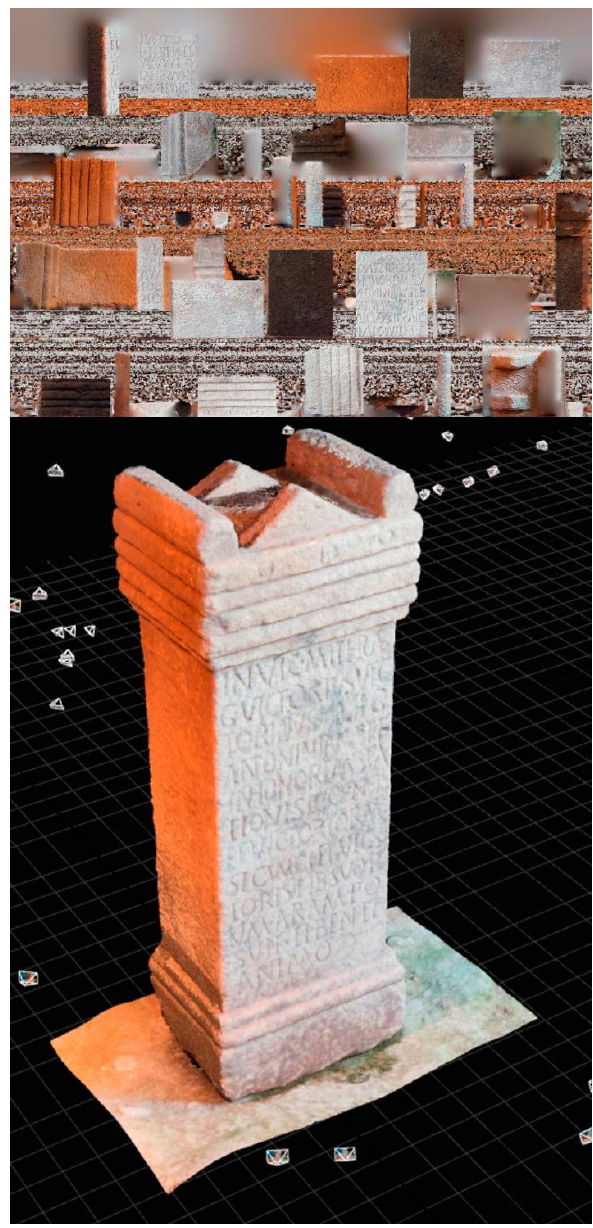
Figure 3. Texturing and high resolution model. Ara votive 12M triqs